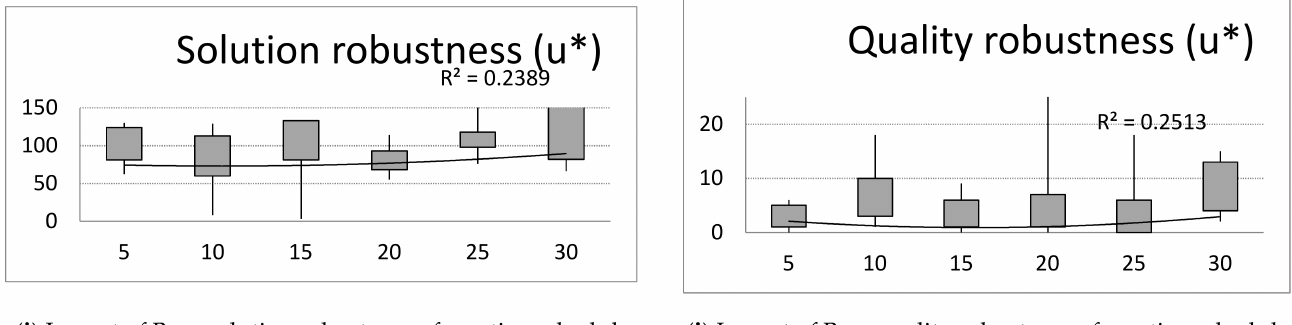
Figure 4. The impact of number of iterations, B = {5, 10, 15, 20, 25, 30} on makespan, flow time, total tardiness, and idle time of predictive schedules (u) and reactive schedules (u*), and solution robustness and quality robustness.